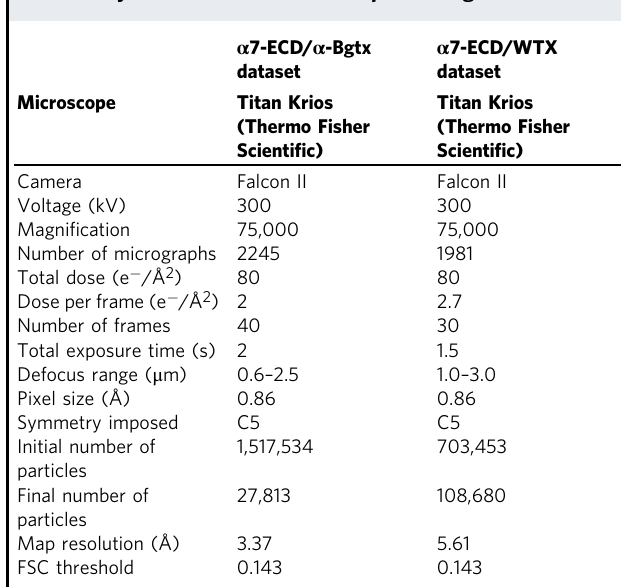
Table 1 CryoEM data collection and